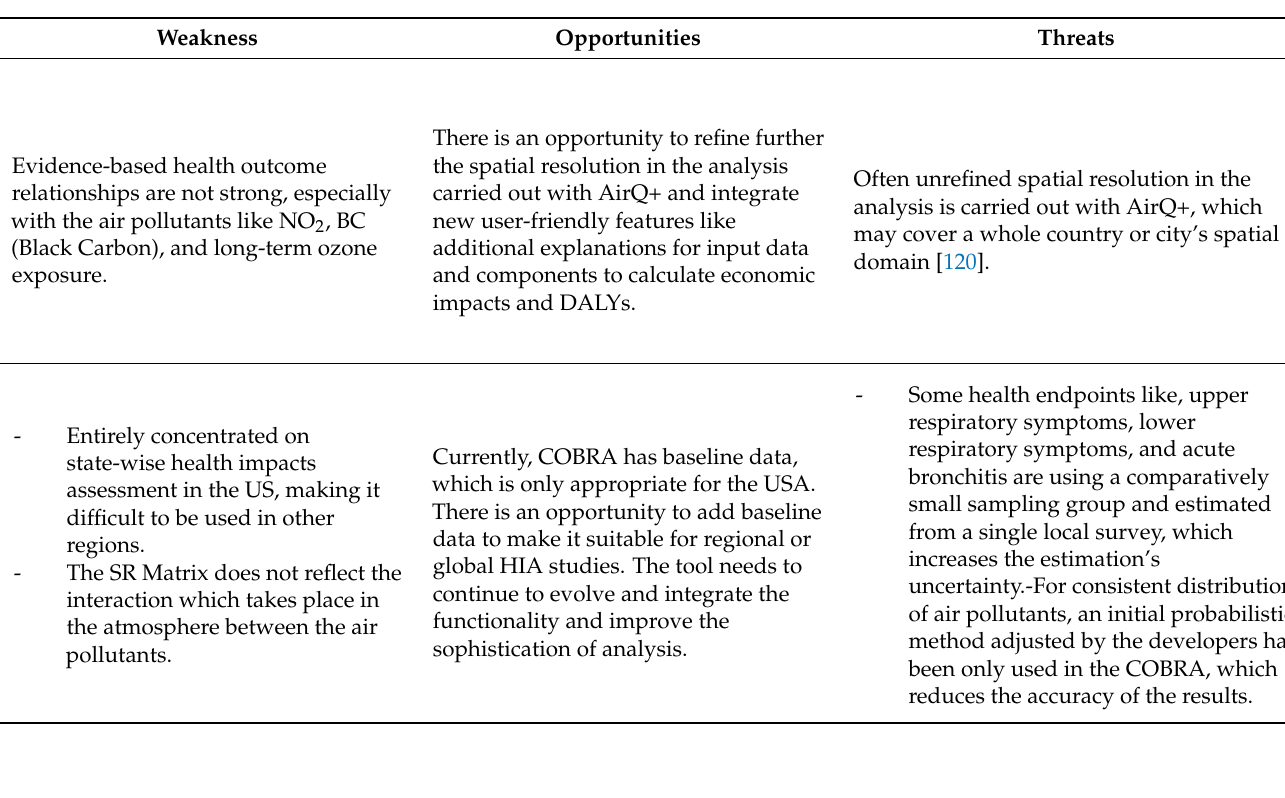
Table 7. SWOT (strengths, weaknesses, opportunities, and threats) analysis of the selected AP-AHP